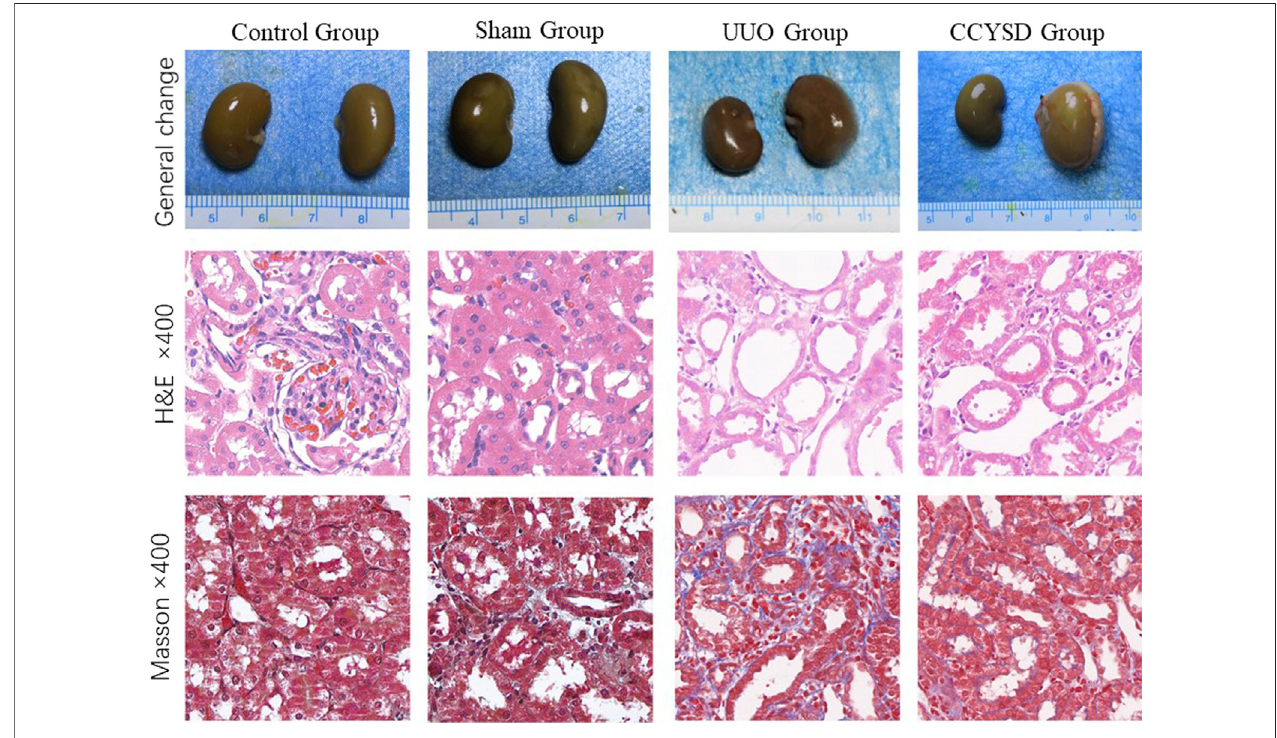
FIGURE 6 | Pathological changes of renal